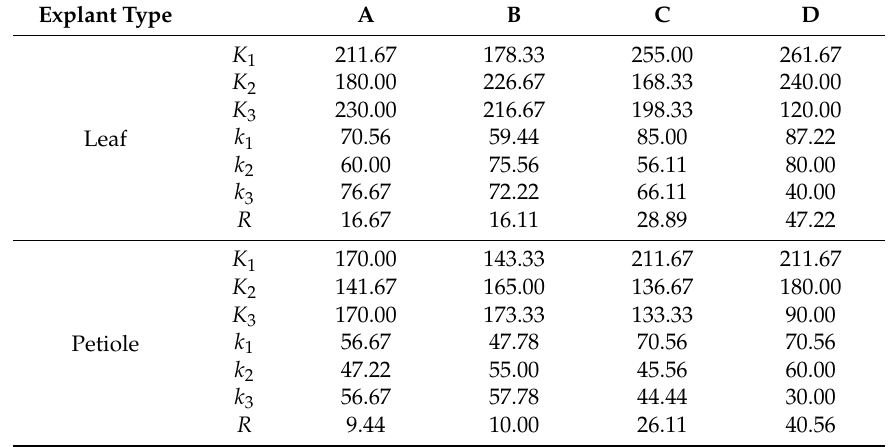
Table 6. The range analysis of the hybrid sweetgum survival rate by orthogonal test.